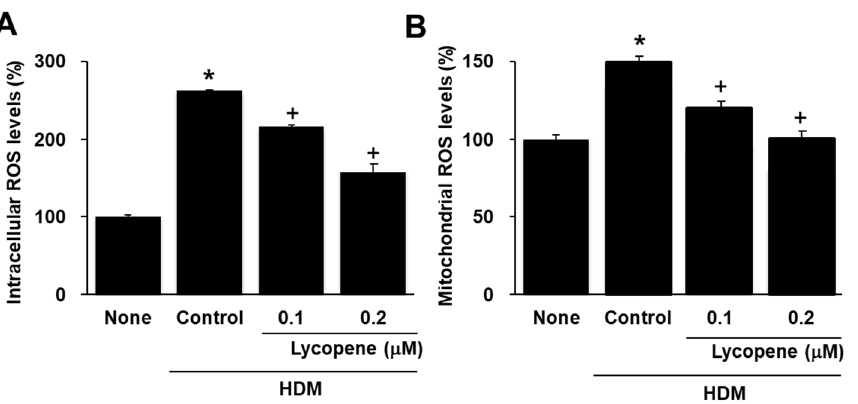
Figure 3. Effects of lycopene on the intracellular and mitochondrial levels of ROS in house dust mite (HDM)-stimulated A549 cells. Cells were pretreated with lycopene (0.1, 0.2 µ M) for 1 h and then with HDM (20 µ g/mL) for 2 h. ( A ) The intracellular ROS levels were determined using DCF-DA. ROS levels of the cells without any treatment (none) were set as 100%. ( B ) The mitochondrial ROS levels were determined using MitoSOX. ROS levels of the cells without any treatment (none) were set as 100% All data are shown as the mean ± S.E. of three independent experiments. * p < 0.05 vs. none (cells without any treatment); + p < 0.05 vs. control (cells with HDM